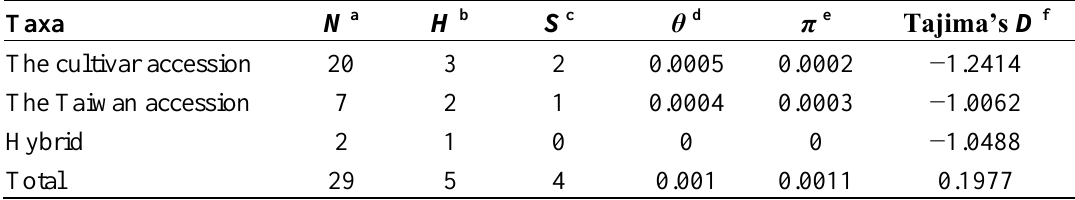
Table 1. Genetic diversity and neutrality tests of the chloroplast atp B- rbc L spacer in the cultivar accession and the Taiwan accession of Momordica charantia (gaps are